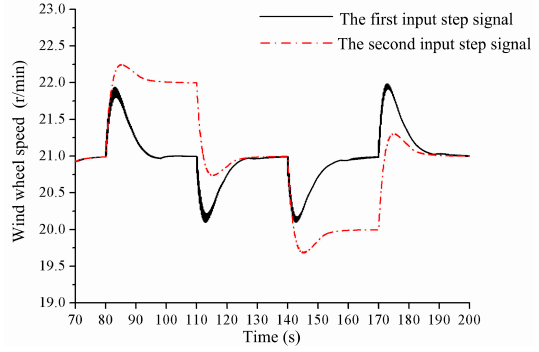
Figure 12. Wind wheel speed curve.